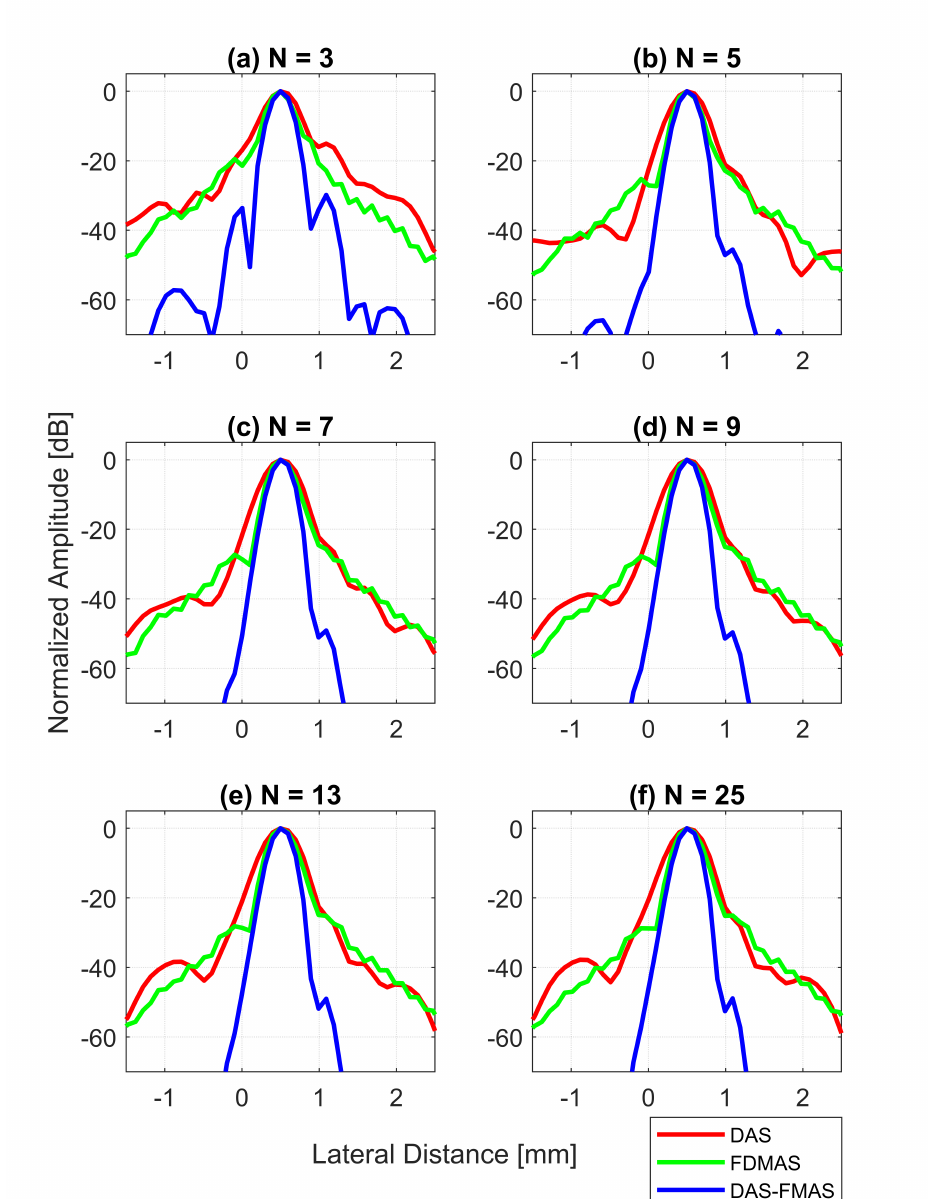
Figure 12. Lateral beam profiles for the wire target at a 30 mm depth with DAS, FDMAS and DAS- FMAS using ( a ) N = 3, ( b ) N = 5, ( c ) N = 7, ( d ) N = 9, ( e ) N = 13 and ( f ) N = 25. Comparing DAS-FMAS to DAS and FDMAS, the main lobe is narrower and the side lobes are attenuated